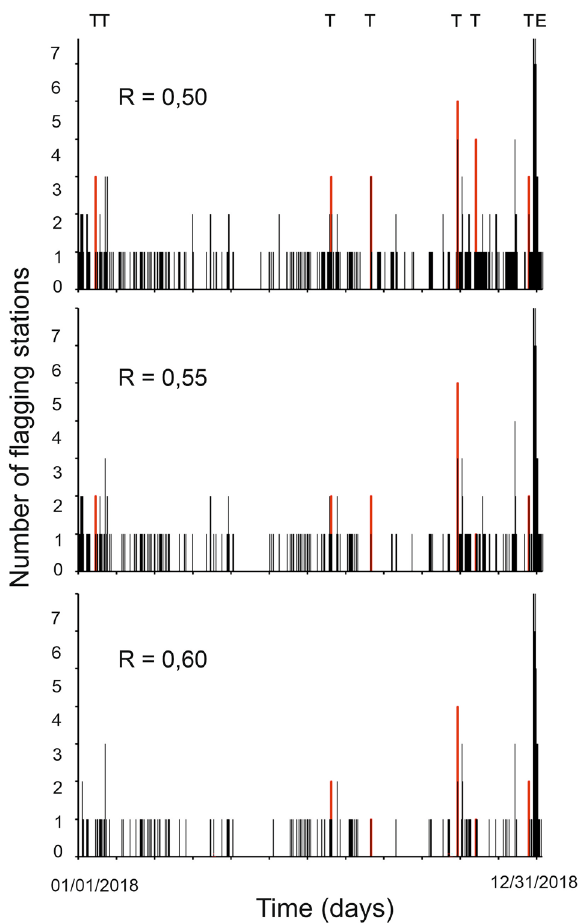
Figure 4. Number of stations that reached or topped three arbitrary threshold values (0.50, 0.55, and 0.60) of the R saturation in 2018. T and E stand for teleseisms and the Christmas Eve eruption, respectively. Red bars mark warnings caused by